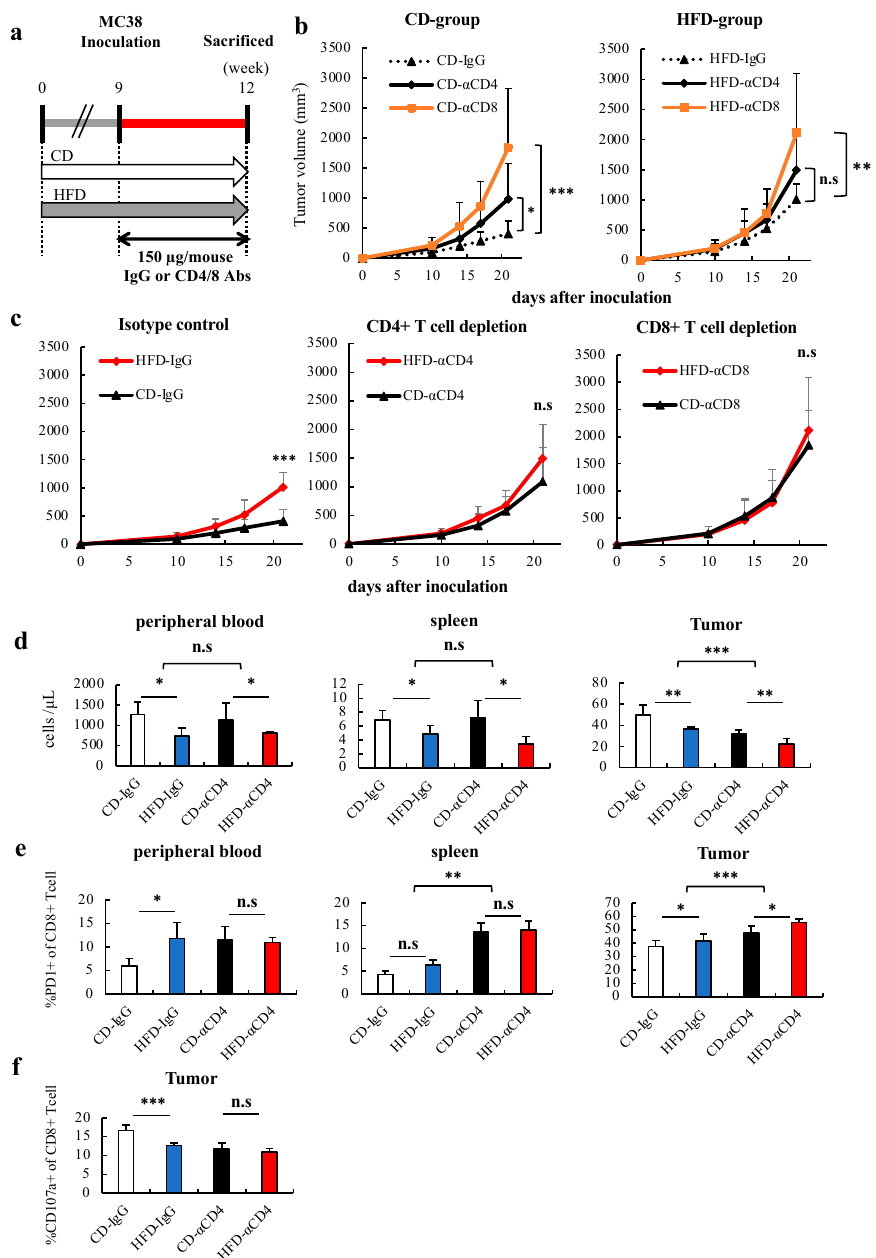
Figure 6. HFD-induced obesity accelerated tumor growth in a CD4+ T cell-dependent manner. ( a ) Experimental schema is shown. After 9 weeks of feeding, the colon cancer cell line MC38 (4 × 10 6 cells) was inoculated subcutaneously on the backs of mice. Anti-CD4 antibodies were administered starting from the day before tumor inoculation, and the effect on tumor progression was observed.